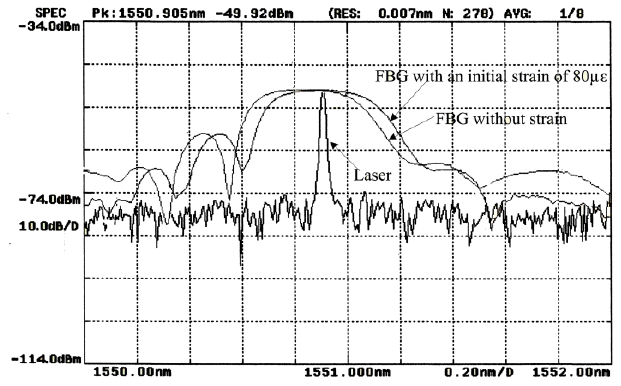
Figure 3. Optical spectra respectively for the laser diode (LD) and FBG with and without initial strain.